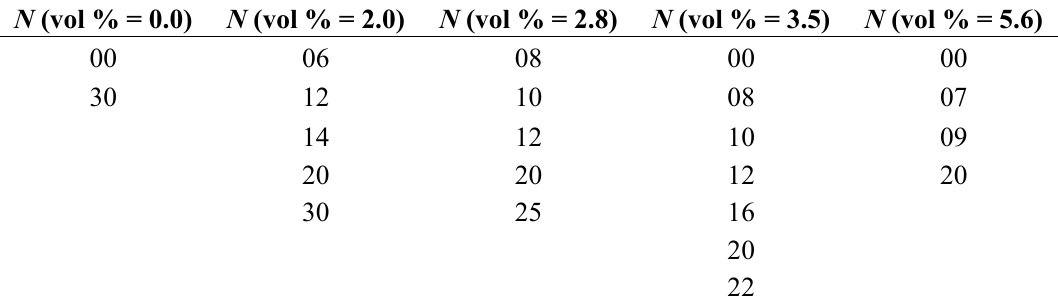
Table 1. Samples studied at the indicated N and the total loading of